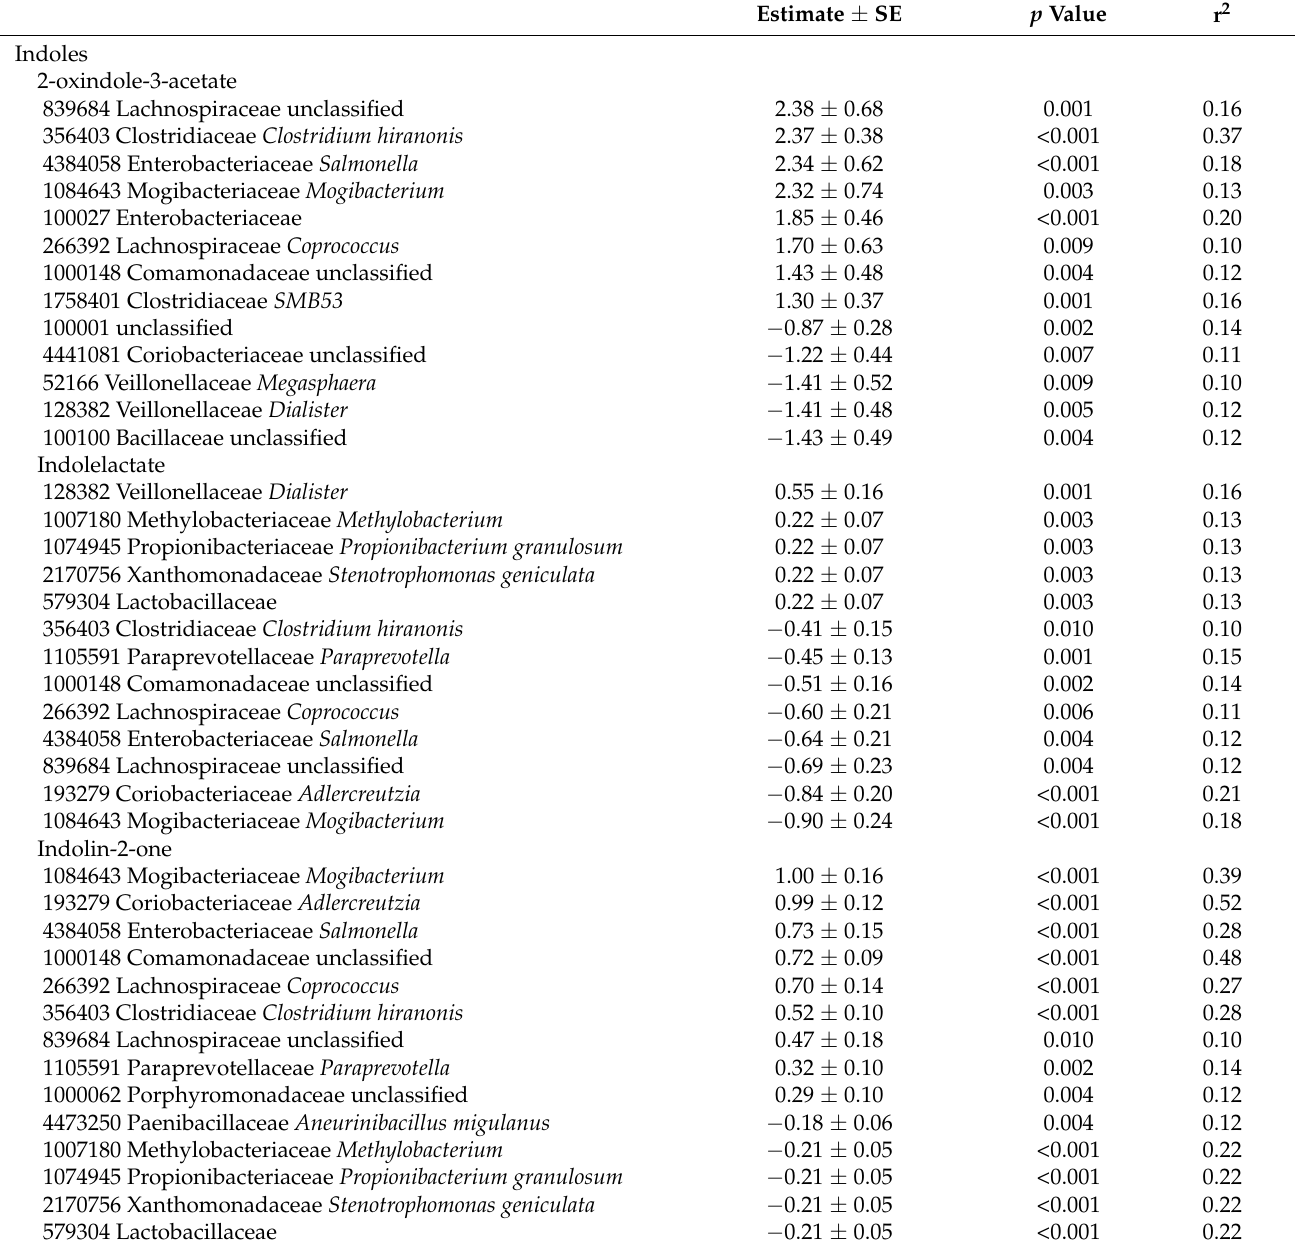
Table 9. Correlations between fecal metabolites and